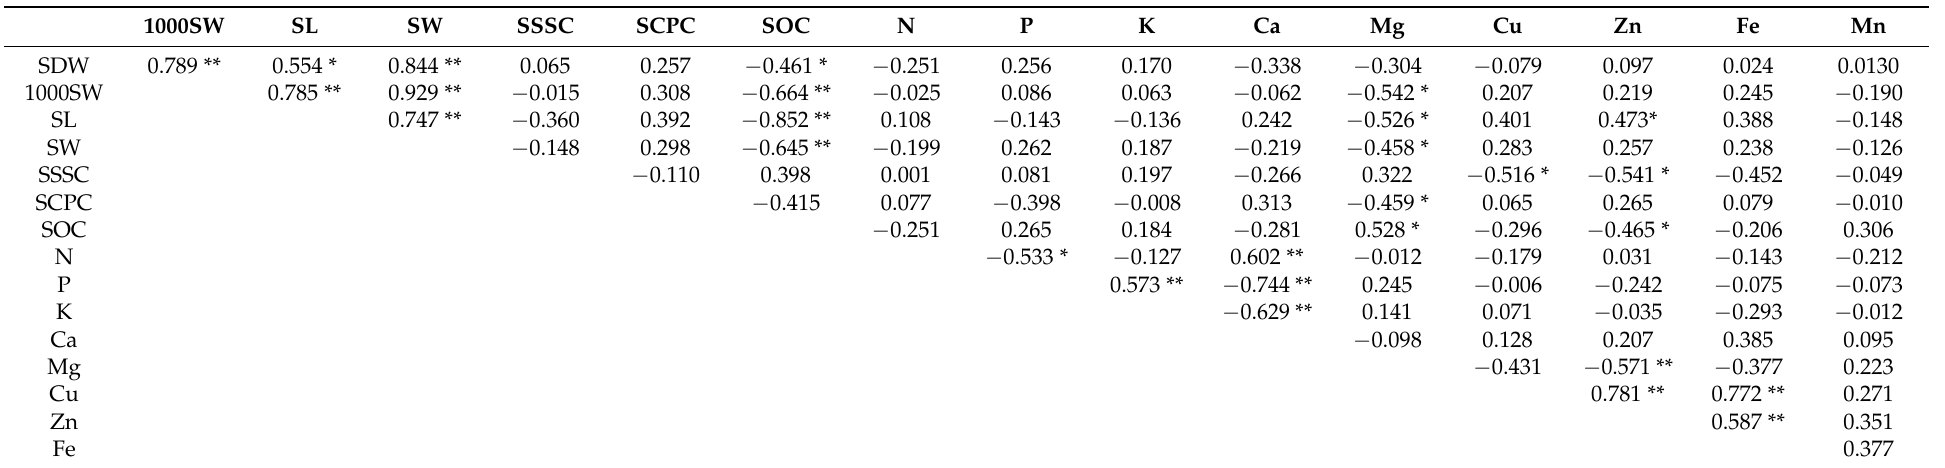
Table 11. Correlation coefficients among seed traits of four provenances of X. sorbifolium